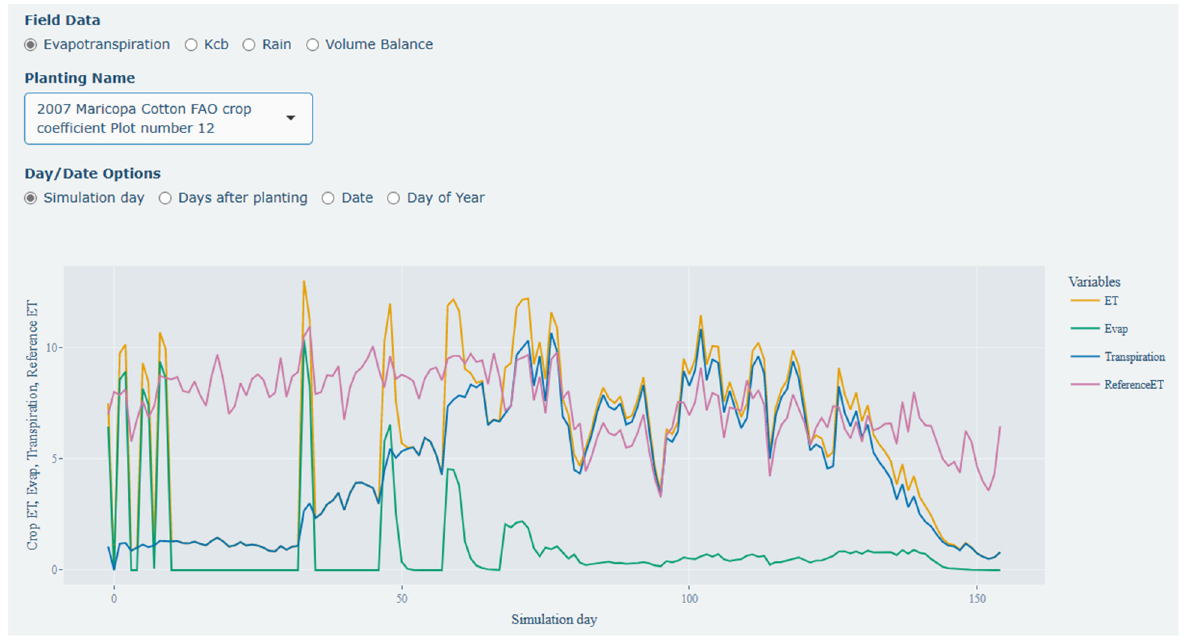
Figure 8. WINDS (Water-use, Irrigation, Nitrogen, Drainage, and Salinity) model simulation (https: